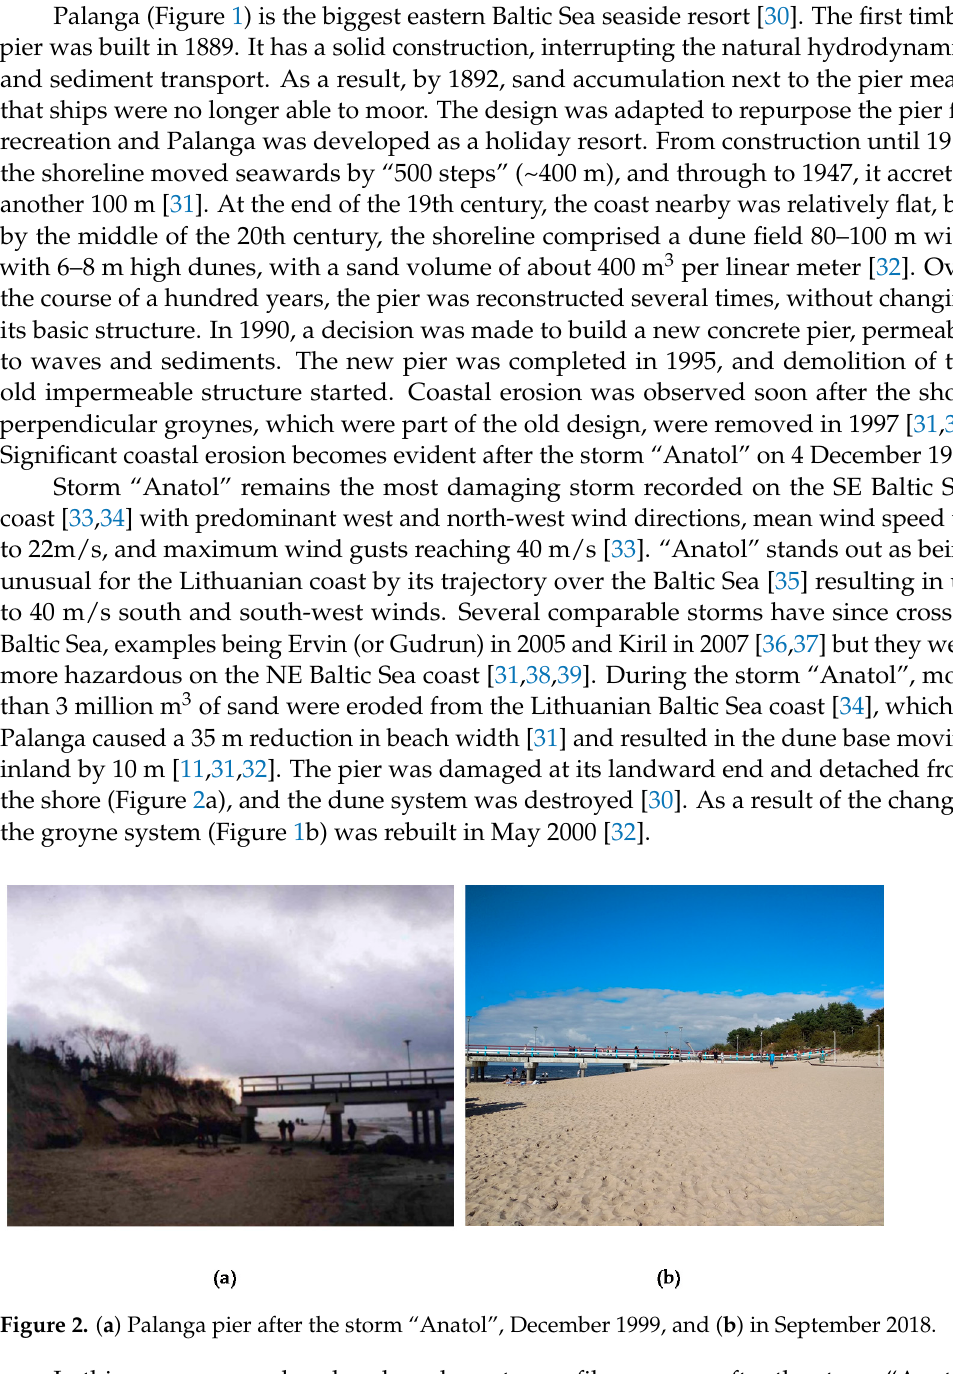
Figure 2 . ( a ) Palanga pier after the storm “Anatol”, December 1999, and ( b ) in September